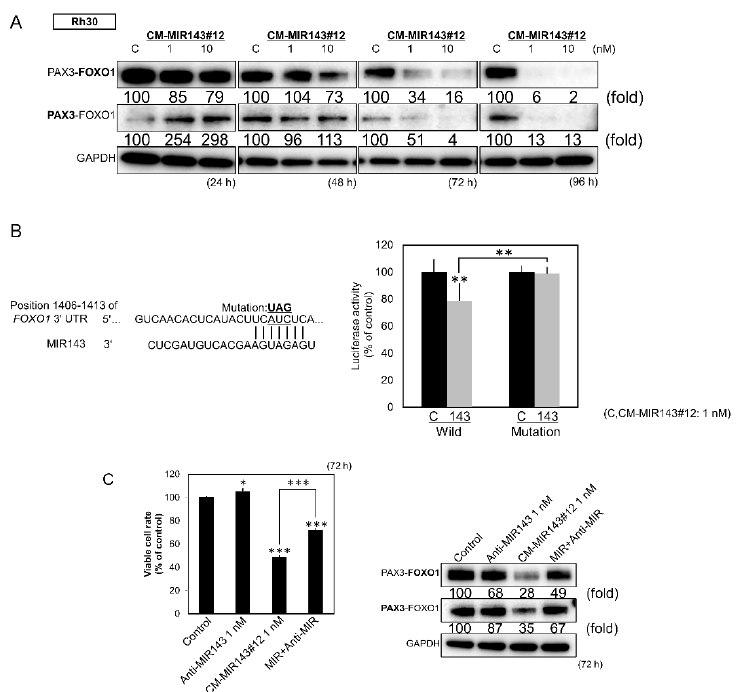
Figure 4. ( A ) Protein expression of PAX3–FOXO1 in Rh30 cells at 24, 48, 72, and 96 h after transfection with CM-MIR143#12 (1, 10 nM). ( B ) Luciferase activities after co-transfection with control RNA or CM-MIR143#12 and wild type or mutant pMIR vectors having the predictive MIR143 binding site in the 3′UTR of FOXO1 . The left part of the figure shows the region of the 3′UTR of human FOXO1 mRNA complementary to the mature MIR143. ( C ) Effect of combined treatment with antagoMIR143/CM-MIR143#12 on the growth of Rh30 cells. Cells were transfected with control RNA or CM-MIR143#12 (1 nM) + antagoMIR143 (1 nM). Left panel: cell viability; right panel: expression level of PAX3–FOXO1 assessed at 72 h after the transfection. PAX3–FOXO1 was detected using the antibody indicated in bold. Results are presented as the mean ± SD; * p < 0.05; ** p < 0.01; *** p < 0.001.